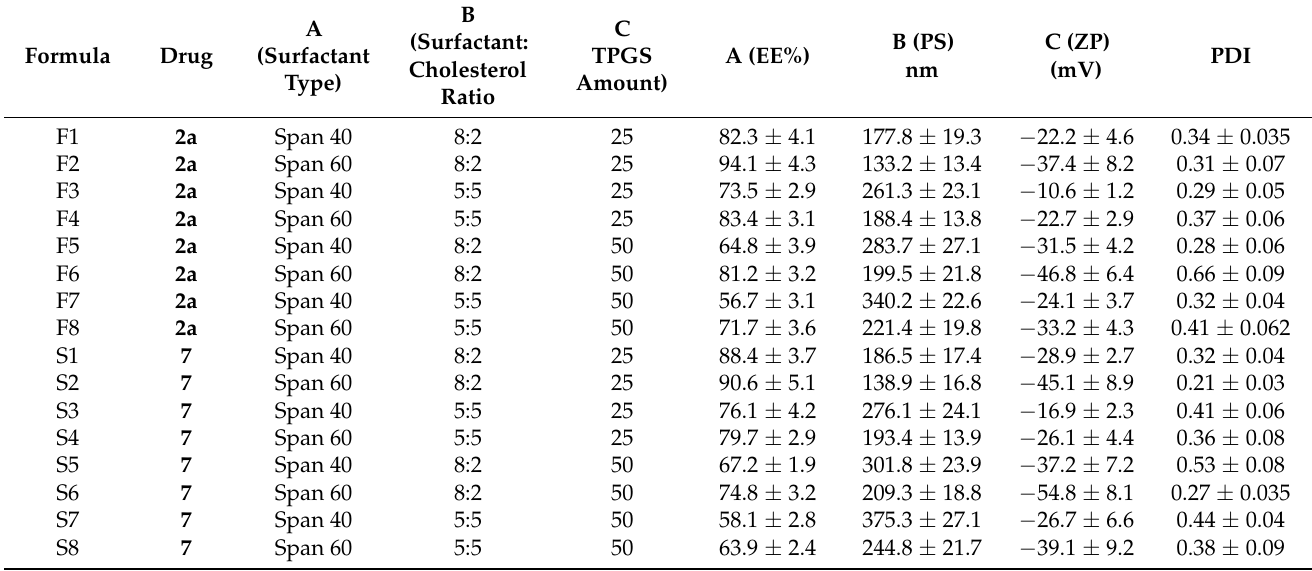
Table 7. The 2 3 full factorial experimental design; Experimental runs, independent variables and estimated responses of 2a and 7 TPGS-modified